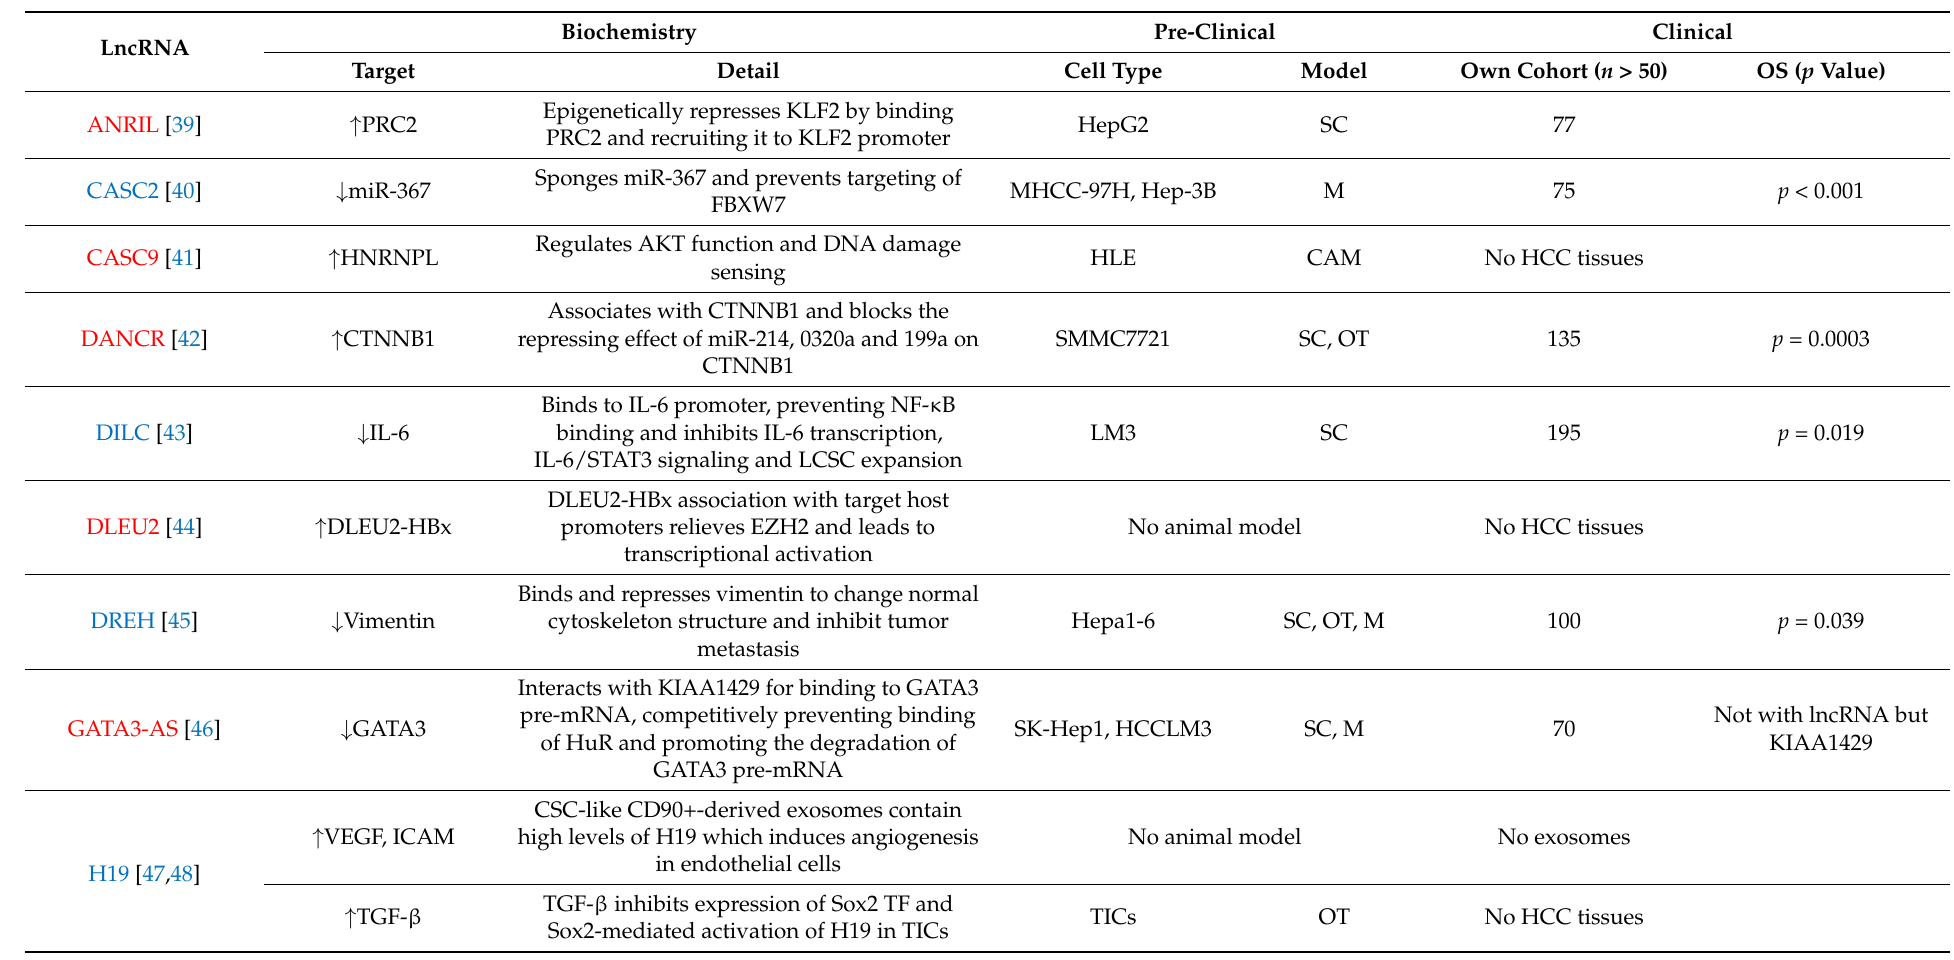
Table 1. List of lncRNAs described in this review. “Biochemistry” shows the molecular mechanism of the lncRNA (target and detail). “Pre-Clinical” describes the cell lines and the animal model used. “Clinical” shows the number of patients studied in an independent cohort and the significance of the association between the expression of the lncRNA and the overall survival. LncRNA names in red denote upregulated lncRNAs, whereas blue denotes downregulated lncRNAs. All candidates are in alphabetical